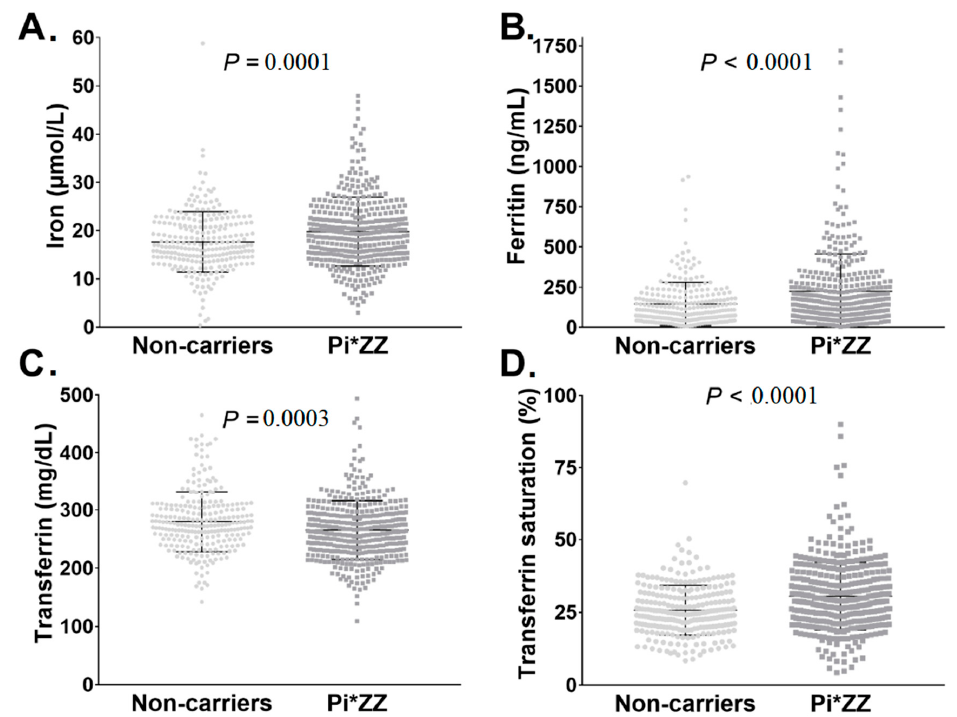
Figure 1. Parameters of iron metabolism in individuals homozygous for the alpha1-antitrypsin Pi*Z variant (Pi*ZZ) and Pi*Z non-carriers. In total, 254 non-carriers and 409 individuals with a homozygous Pi*Z mutation (Pi*ZZ) were analyzed. Scatter plots depict serum iron (adjusted p value = 0.0002) ( A ), serum ferritin (adjusted p value = 0.000003) ( B ), serum transferrin (adjusted p value = 0.0037) ( C ), and serum transferrin saturation (adjusted p value = 1.0 × 10 − 7 ) ( D ). Multivariable adjustments were performed for the covariates age, sex, BMI, presence of diabetes mellitus, and mean alcohol